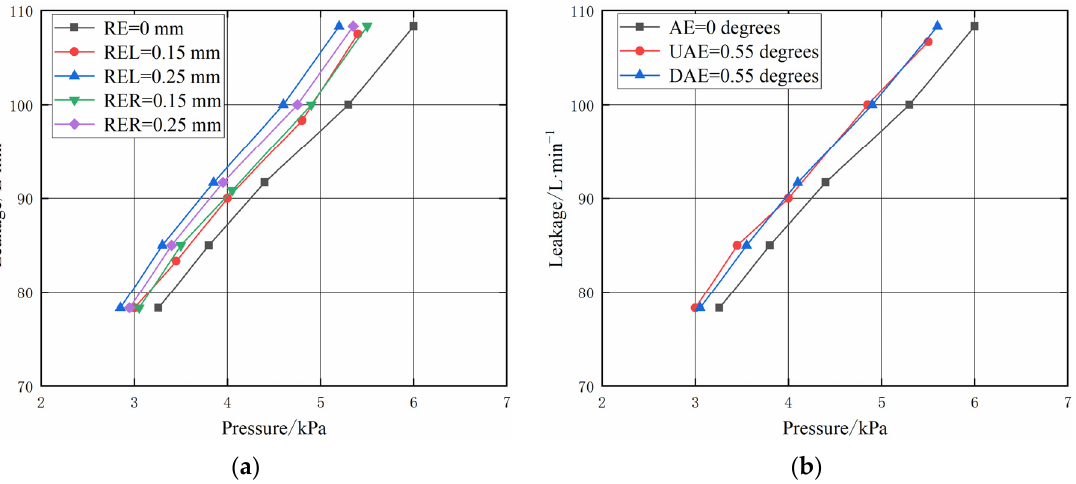
Figure 18. Leakage of hybrid labyrinth–honeycomb seal under different eccentricities. ( a ) Radial eccentricity; ( b ) angular eccentricity.